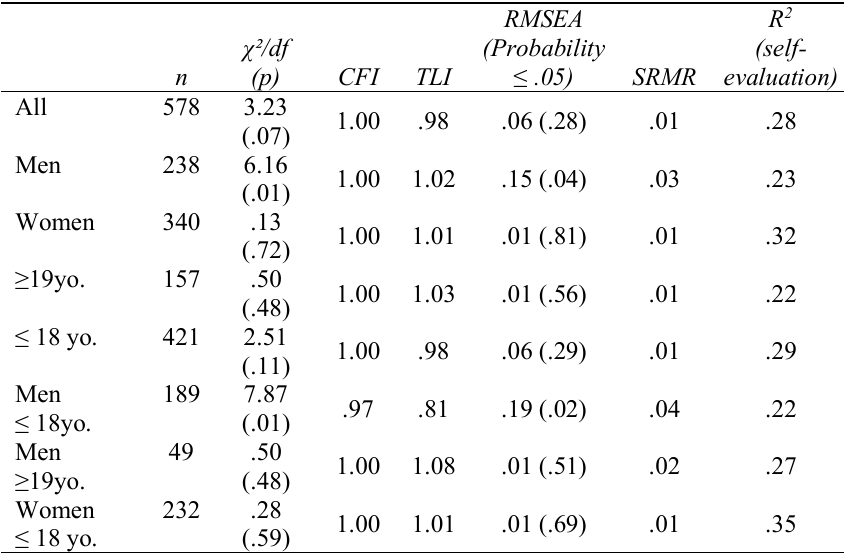
The fit indexes for a model of the knowledge of